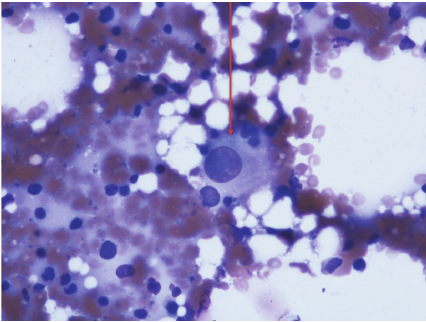
Figure 6: Bone marrow aspirate smear: dysplastic megakaryocyte, 100x magnification megakaryocyte with nuclear hypolobation.